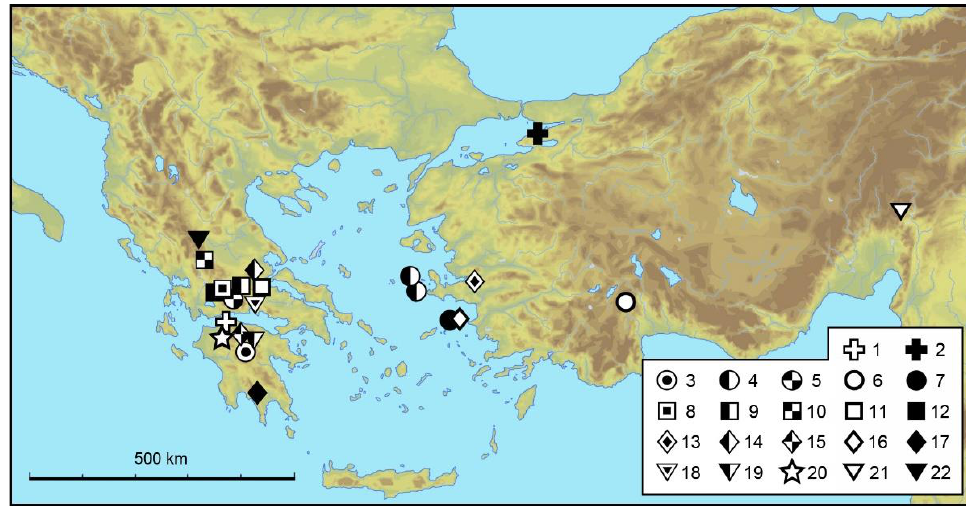
Figure 6. Distribution map of genus Caecoparvus . 1: C. achaiae ; 2: C. anatolicus; 3: C. arcadicus ; 4: C .